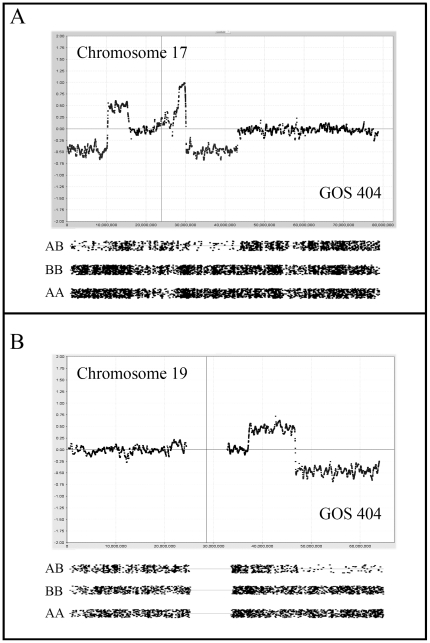
Complex CNAs in WT.In (A) two regions of deletion on chromosome 17 are seen in GOS 404, in both cases accompanied by amplification at adjacent regions. LOH is seen for the two deleted regions. In (B) deletion of the distal part of 19q is seen in GOS 404 which is accompanied by LOH with a preceding region of gain on 19q.